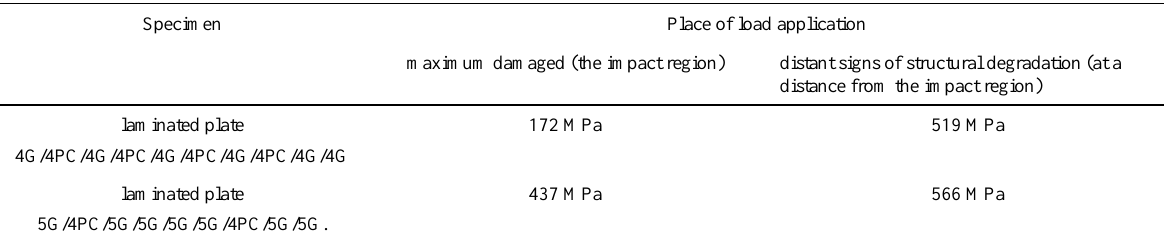
Table 1: Secant effective modulus of elasticity E ef of ballistic damaged